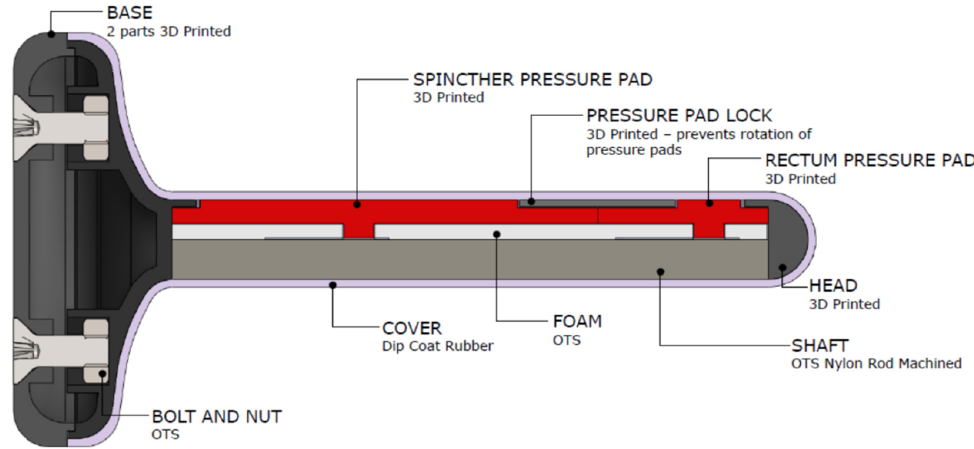
Figure 3. Sensing probe design and key